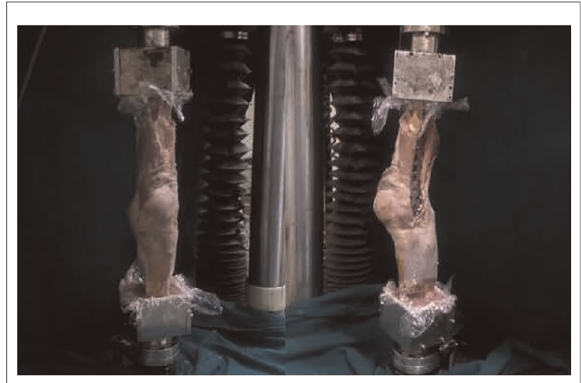
FIGURE 4 Model of internal rotatory deformity. The specimens were assembled to the BOSE Electroforce 3520-AT biomechanical testing machine.